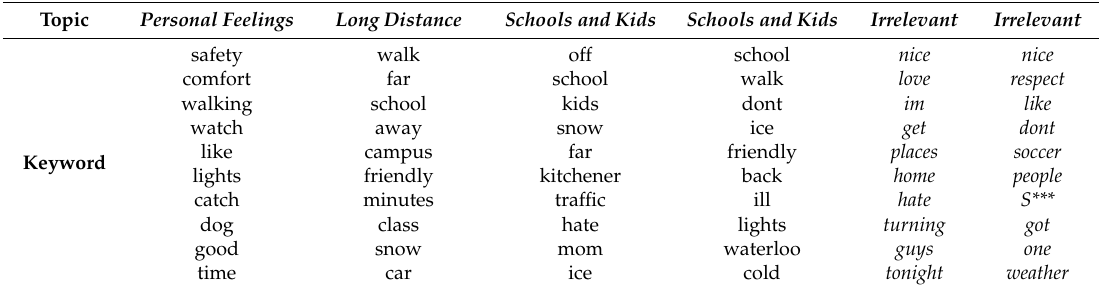
Figure 8. Spatial distributions of walking related tweets. Table 2. Examples of keyword list generated from